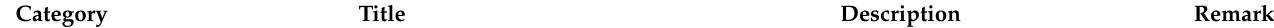
Table 4. Classification and description on decision-making hierarchy of LNG bunkering method selection in a shipyard.